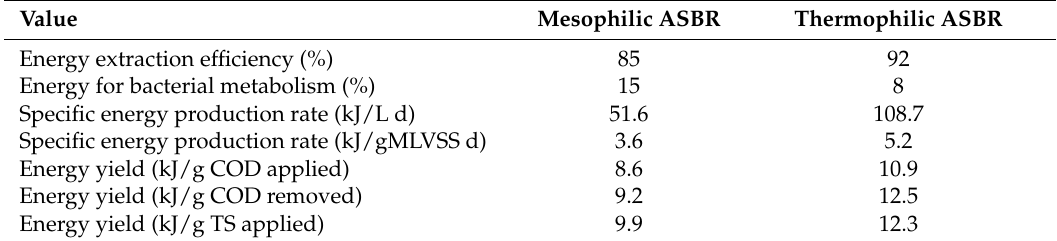
Table 5. The energy balance of the ABR system operated at a mesophilic or thermophilic temperature under steady state conditions at the optimum COD loading rates of 6 and 10 kg/m 3 d, respectively (with S.D. less than